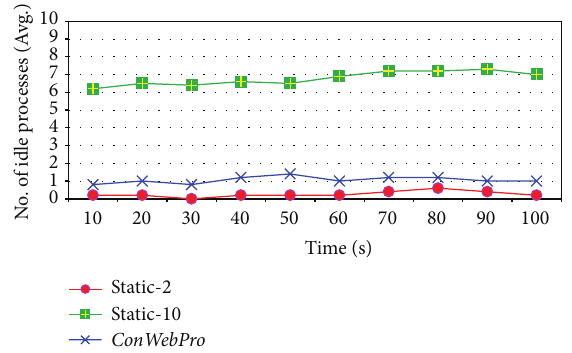
Figure 11: The average idle processes at Clark Net web